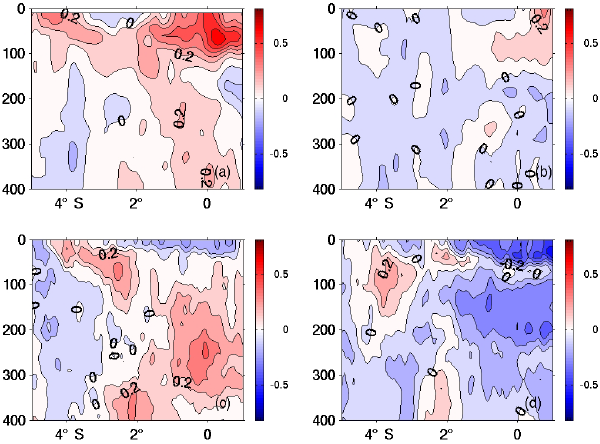
Figure 8. Zonal ADCP velocity sections (in ms − 1 ; positive east- ward; contour interval 0.1ms − 1 ) on the meridional path from 1 ◦ N to 5 ◦ S at 85 ◦ 50 (cid:48) W (a) in March 1993, (b) in February 2009, (c) in November 2012, and (d) from 1 ◦ N to 2 ◦ 30 (cid:48) S at 85 ◦ 30 (cid:48) W and di- agonal to 5 ◦ S, 84 ◦ 12 (cid:48) W in October 2015 (see Fig.